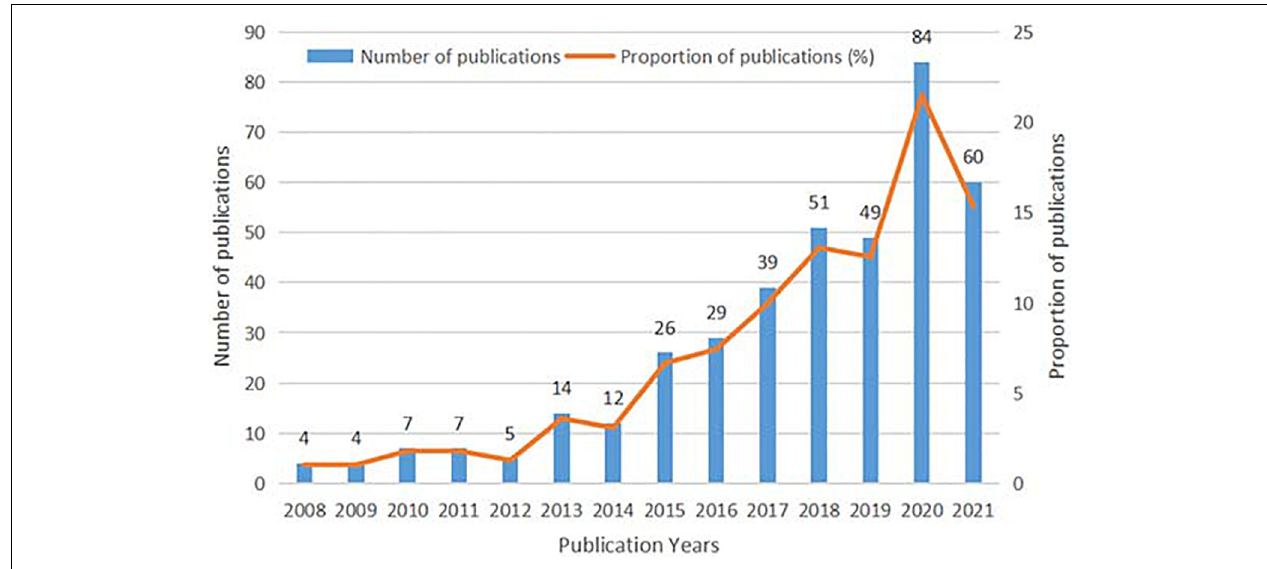
FIGURE 1 | The distribution of the bibliographic records per